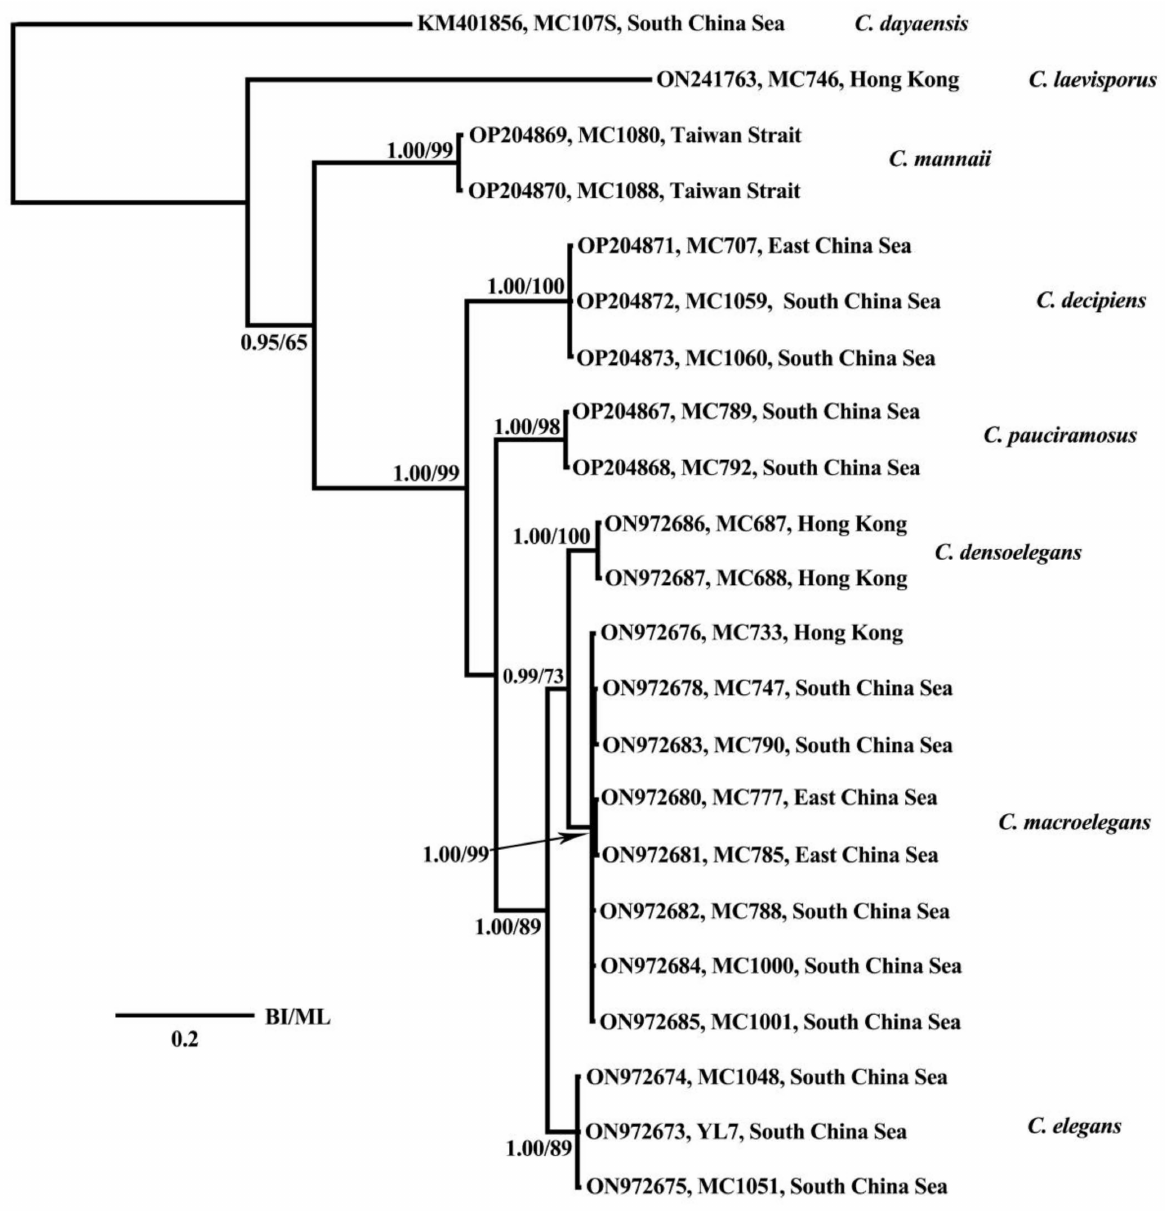
Figure 6. Phylogenetic tree based on maximum likelihood analyses of the ITS rDNA sequences. Only bootstrap support from Bayesian analyses (MrB) ≥ 0.95 and maximum likelihood (ML) ≥ 70% are